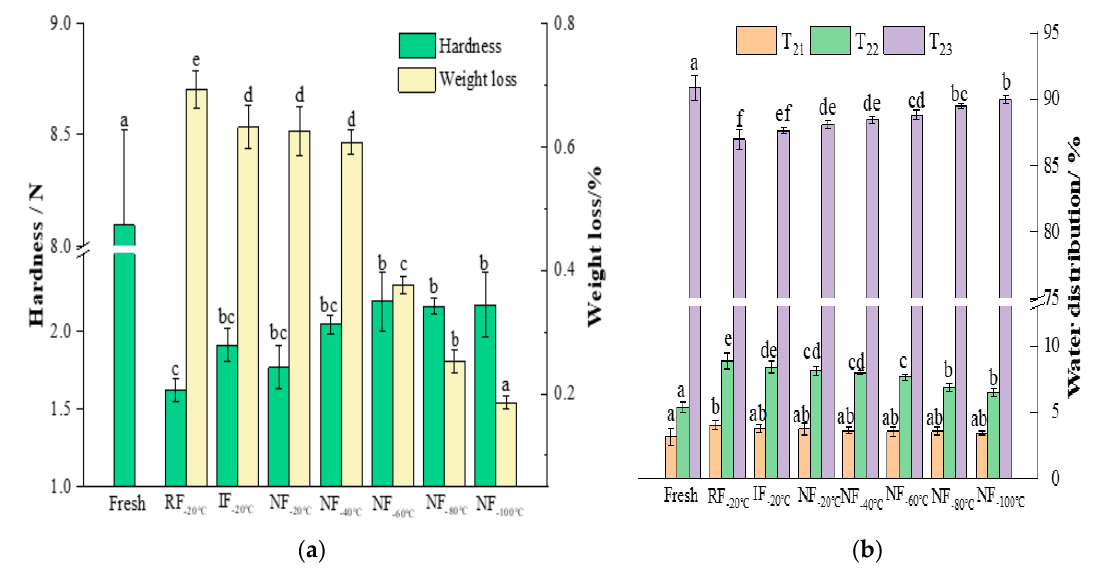
Figure 2. Comparisons of hardness and weight loss of blueberry under different freezing processes: ( a ) hardness and weight loss and ( b ) distribution of water states.